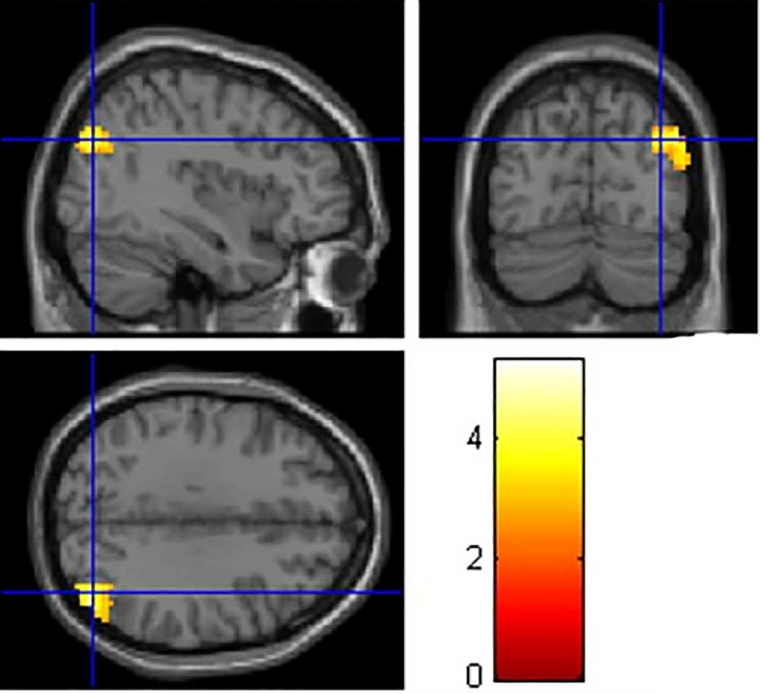
Fig 3. Brain areas showing stronger RSFC with left IFG related to shifting. The coordinates of the cross are [39,–75,